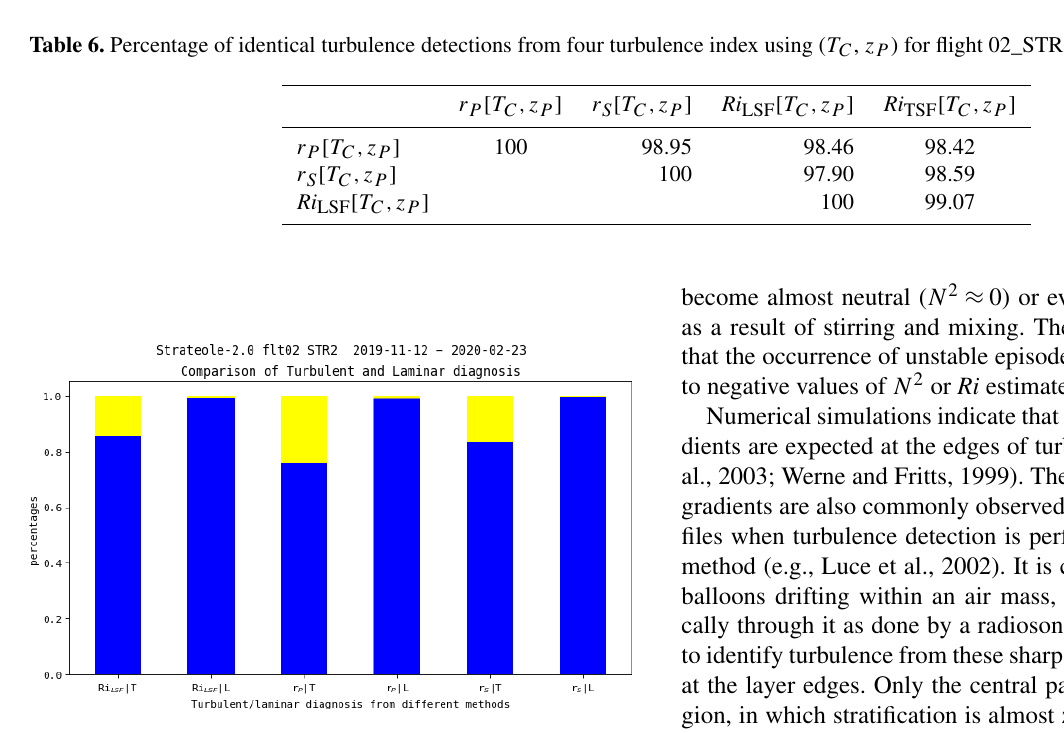
Figure 14. Percentages of true (similar) and false (different) detec- tions for turbulent (T) and laminar (L) episodes diagnosed by the Ri TSF criterion. The three estimators, Ri LSF , r P , and r S , are com- pared to Ri TSF . The rate of agreement is larger than 99% in the case of laminar flow and about 80% in the case of turbulent